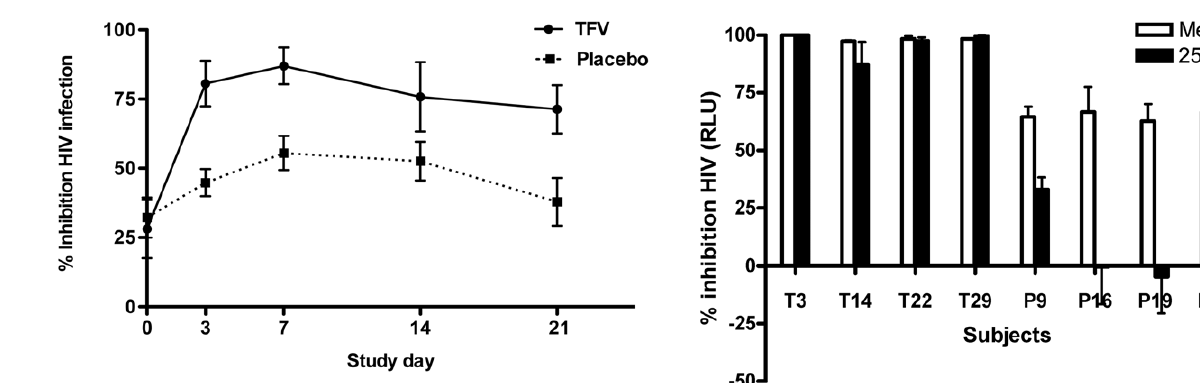
Figure 3. Anti-HIV activity of TFV persists if virus is introduced in semen. TZM-bl cells were treated with CVL collected from four subjects in the TFV group (T) and 4 from the placebo group (P) on Day 7 and then challenged with HIV-1 BaL diluted in medium alone or in medium containing 25% pooled whole human semen. Results are presented as mean percentage inhibition 6 SE obtained from two or three independent experiments, each conducted in triplicate.